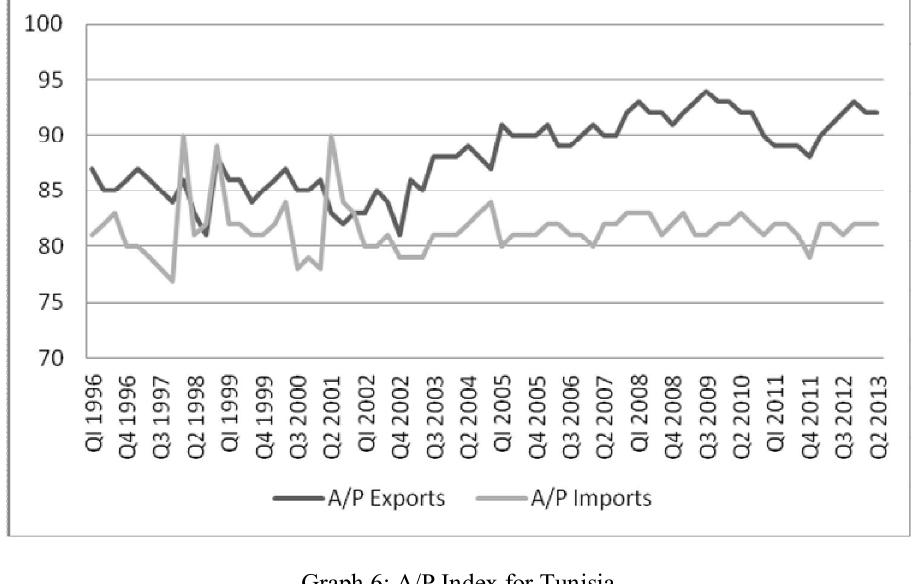
Graph 6: A/P Index for Tunisia